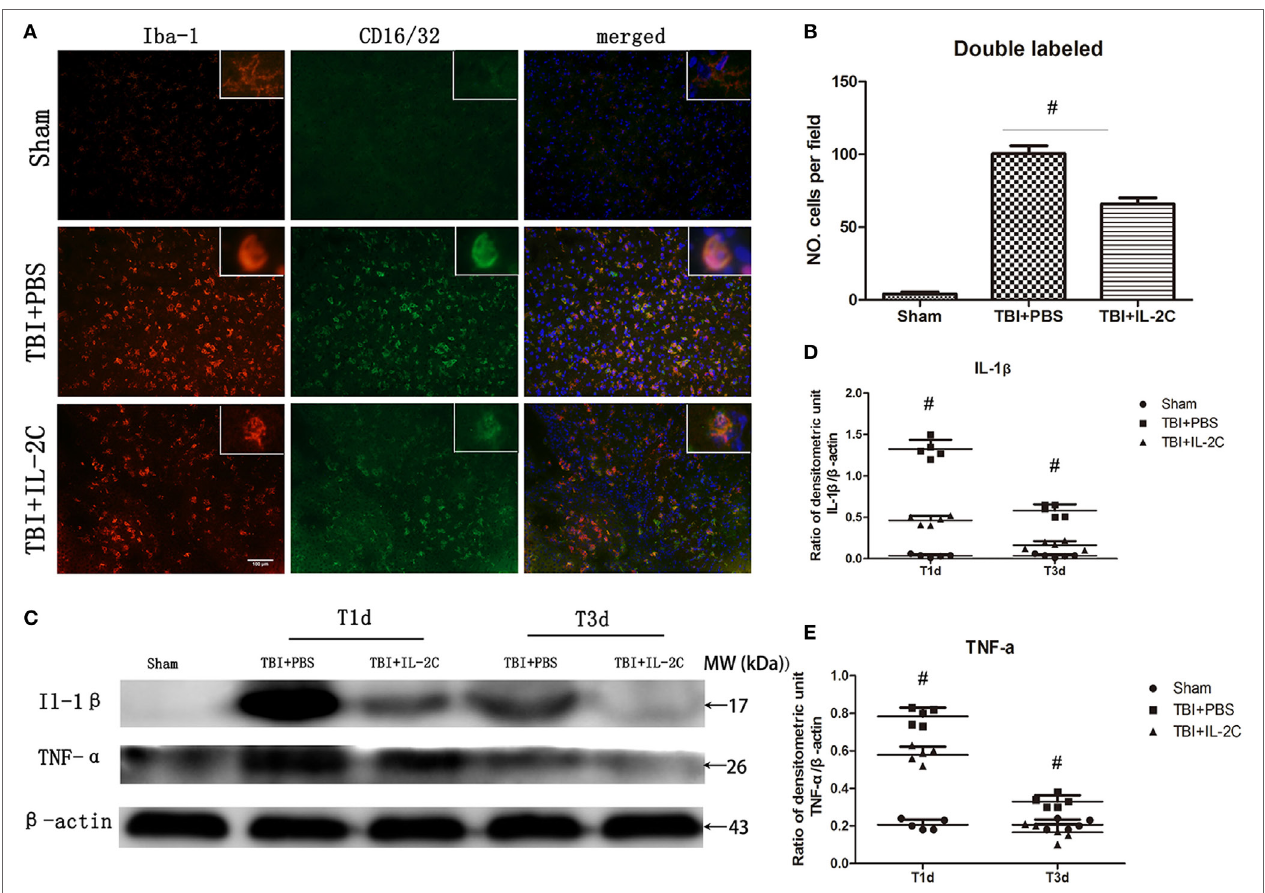
FigUre 10 | Post-injury IL-2C administration suppressed the expression of M1-associated markers around the lesion area. (a) Co-localization of CD16/32 with the microglia marker Iba1 in the contusion area on day 3 post-injury showed that treatment with IL-2C markedly reduced the amount of M1 microglia. (B) Cell count analyses indicated that IL-2C significantly reduced the number of CD16/32 and Iba-1 double-positive cells. (c–e) The traumatic brain injury (TBI)-induced expression of IL-1 β and TNF- α in the ipsilateral cortices on days 1 and 3 post-injury was inhibited by treatment with IL-2C. Data are presented as the mean ± SD; * p < 0.05 and # p < 0.01 ( n = 5